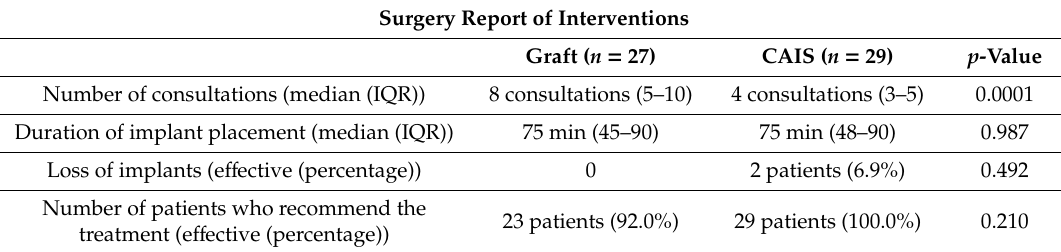
Table 2. Surgery report of